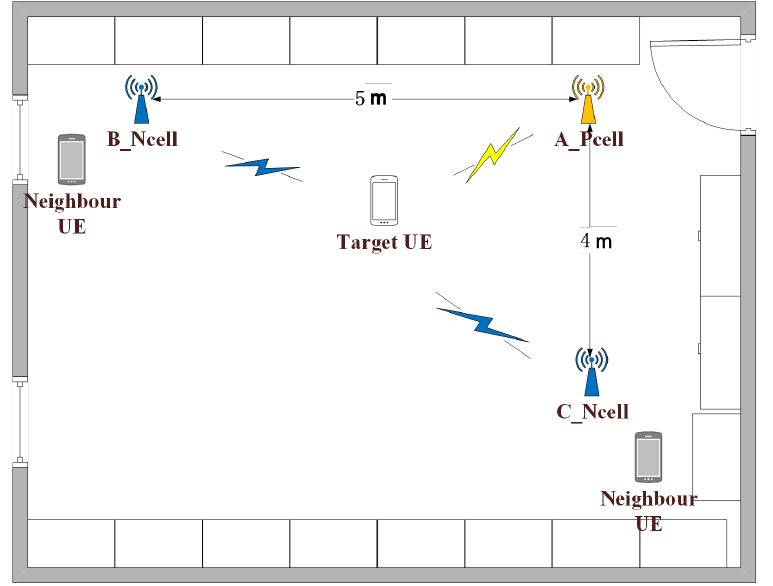
Figure 7. The map of the indoor test